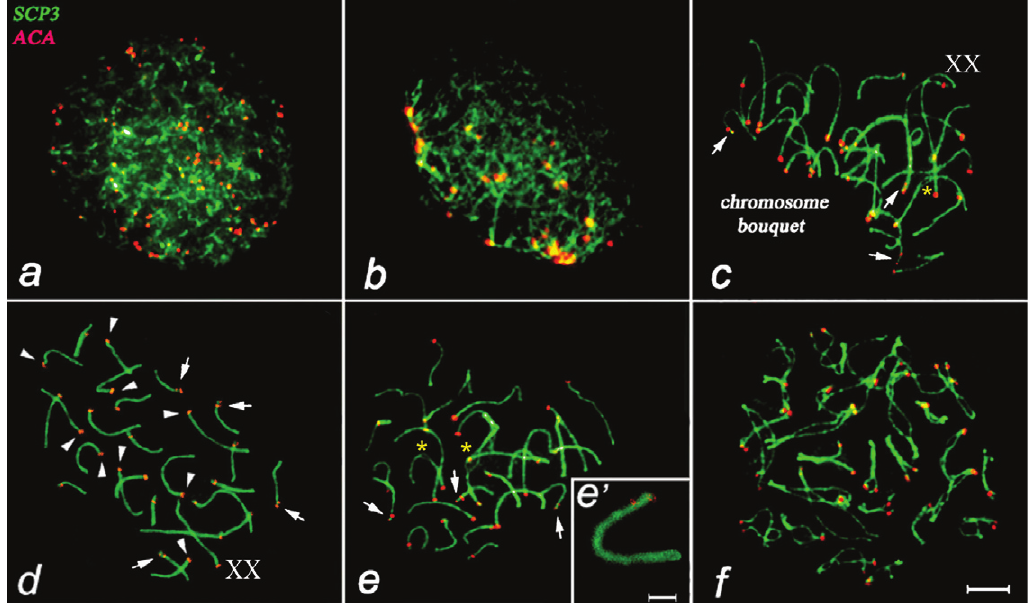
Fig. 1, a-f. Spreads from E. talpinus oocytes immunolabeled with antibodies to the centromere (red) and SCP3 (green). a - preleptotene. Centromeres (red) are scattered over the nucleus. Only short fragments of the axial elements (green) have been formed. b - early zygotene. The formation of the axial elements and bouquet confi guration is visible. c - Early pachytene. All 27 SCs have already been formed. Most SCs are in the bouquet confi guration, except sex bivalent (XX). d - middle pachytene. Two ACA signals lie on distance from each other on four SCs (arrows). Short arms of some chromosomes are not visible (arrow heads). e - early diplotene. Two ACA signals lie on distance from each other on three SCs (arrows). Asynaptic zone of two SCs are visible (snowfl ake). e' - two signals of the ACA on SC lie on distance from each other. Bar=1 μm. f - middle diplotene. Desynapsis of chromosomes begins in the telomeric ends and in the interstitial regions of bivalents. Immunolabeling of SCs with antibodies to SCP3 has the banding pattern. Bar = 3